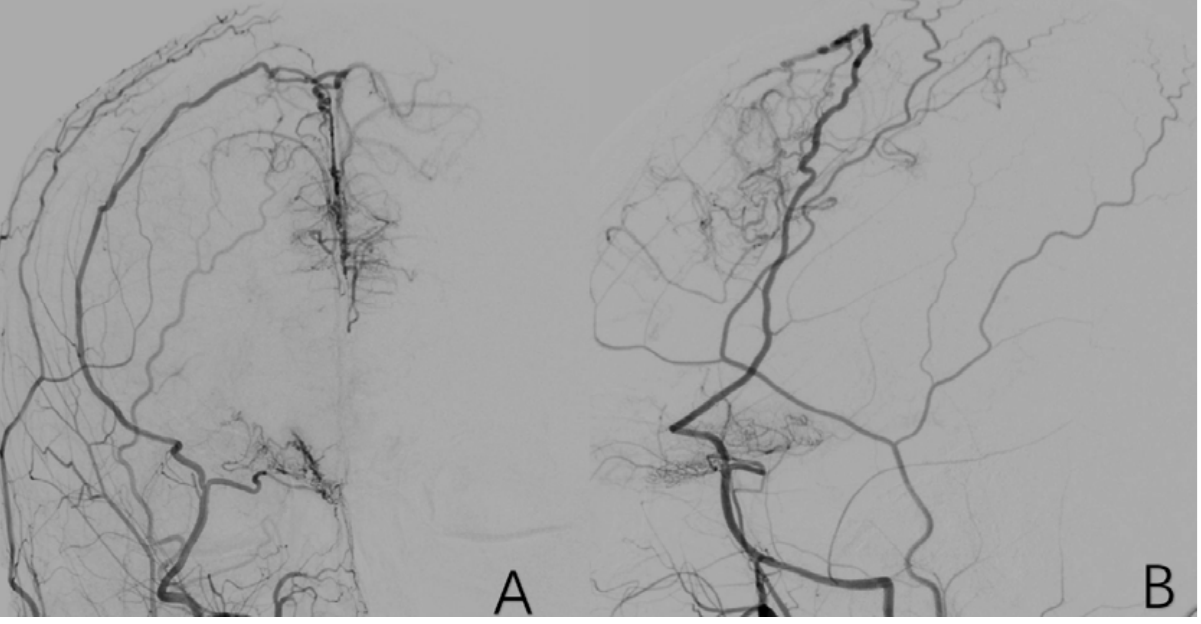
Figure 10. ( A , B ) is a 9 ‐ year ‐ old female with a right ‐ sided external carotid arteriogram showing compensatory blood supply from the right middle meningeal artery to the cranial area.